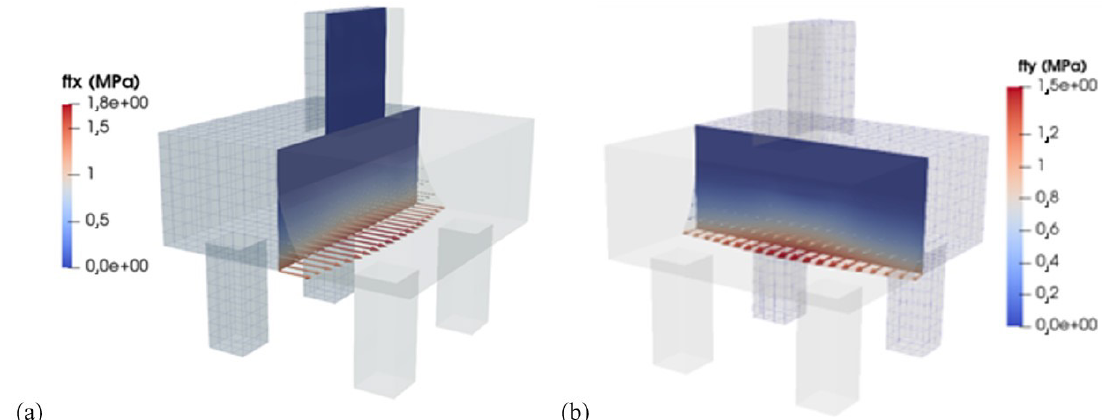
Figure 13. Four-pile cap analysis: reinforcement equivalent stresses (a) f tx and (b) f